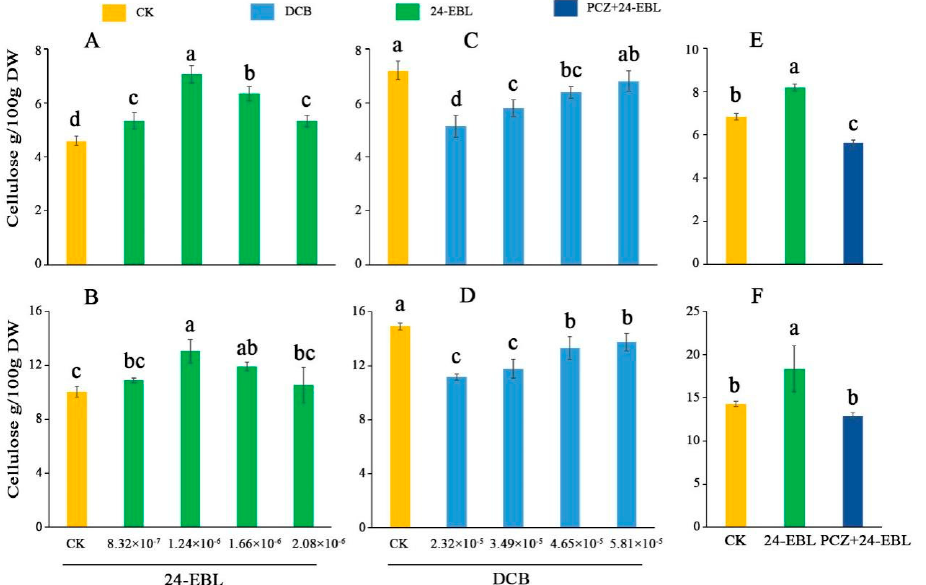
Figure 8. The cellulose content in the petioles and leaf blades of celery under 24-EBL/PCZ/DCB treatments. ( A , C , E ) The cellulose content of celery leaf blades. ( B , D , F ) The cellulose content of celery petioles. Column diagrams with different colors represent the data from celery plants in the CK, 24-EBL, DCB and PCZ + 24-EBL treatment groups. Data are expressed as the means ± standard deviation (SD) of three replicates. Different letters indicate significant difference at 0.05 level. 3.6. Expression Patterns of the Cellulose ‐ Related Genes in Petioles, Leaf Blades and Hypocotyl of Celery under 24 ‐ EBL, PCZ and DCB Treatments AgCESA1 , AgCESA2 , AgCESA3 , AgCESA4 , AgCESA5 and AgCESA8 genes involved